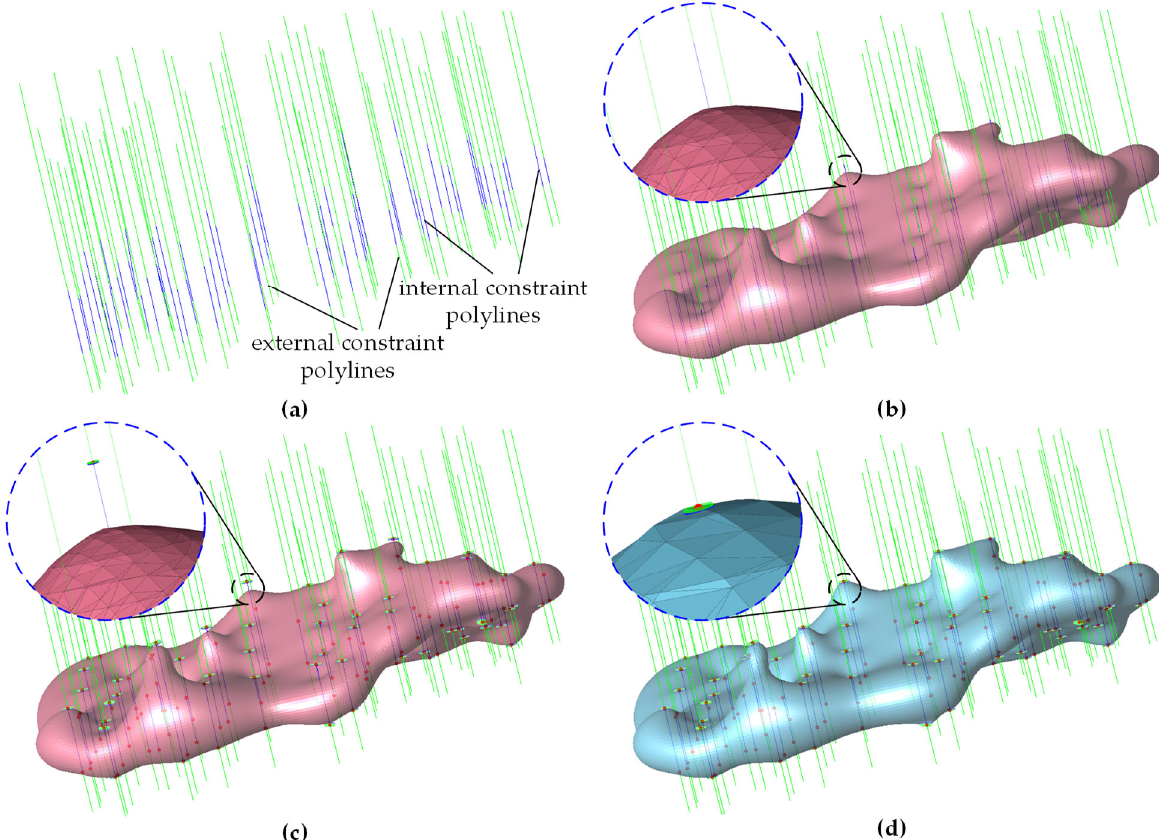
Figure 10. The test result of the snapping of feature points. ( a ) shows the borehole constraints. ( b ) shows the implicit modeling results of the ore body. ( c ) shows the orebody model before the snapping of feature points. ( d ) shows the orebody model after the snapping of feature points.